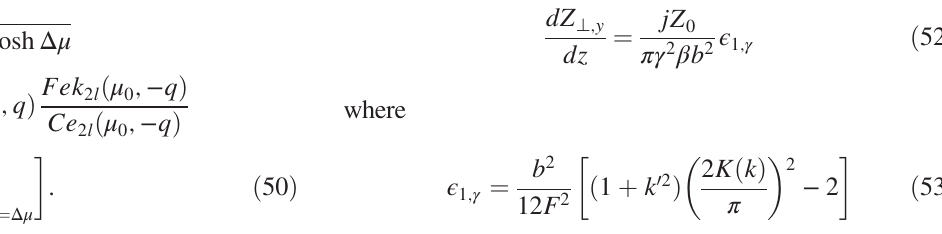
ffiffiffiffiffiffiffiffiffiffiffiffiffi p 1 − k 0 2